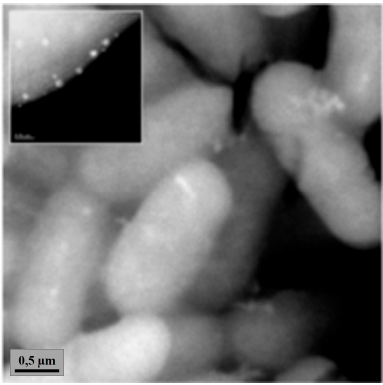
Figure 2. Accumulation of silver nanoparticles in P. aeruginosa cells (silver nanoparticle concentration 75 µg/mL, silver size: 10 nm). Reprinted from [23] with Copyright Clearance Center permission.